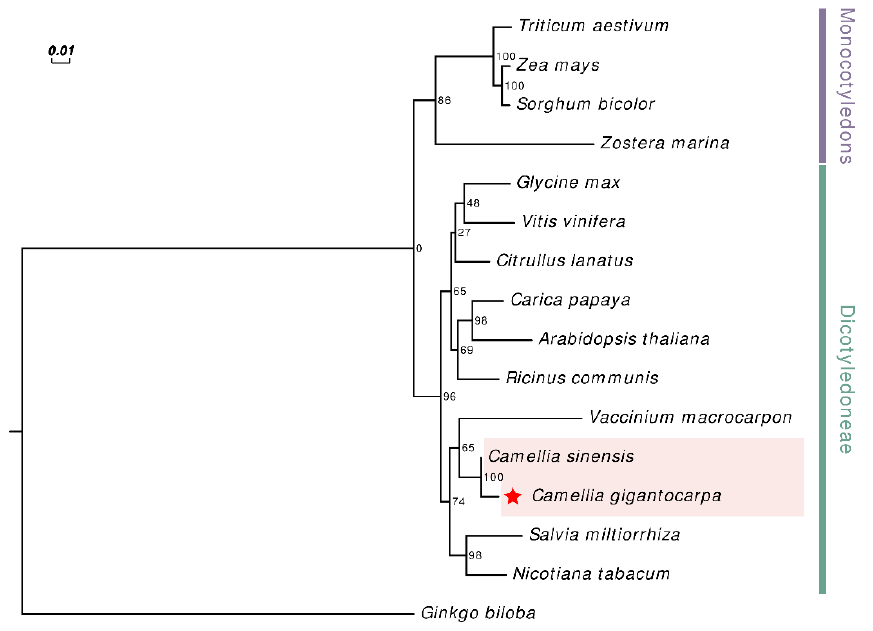
Figure 6. Maximum likelihood tree based on 12 genes common in the 16 plant mitochondrial ge- nomes.